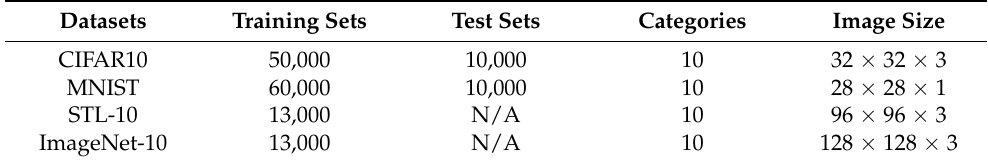
Table 1. Statistics of the Different Datasets.